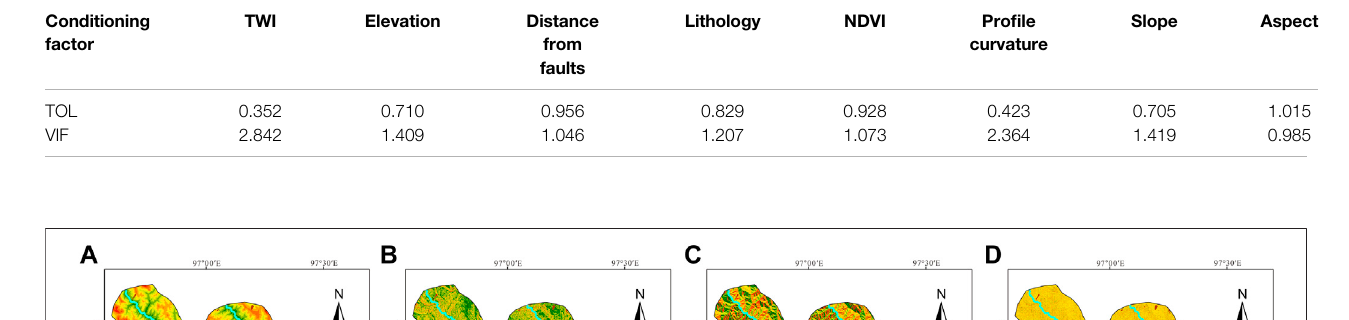
TWI Elevation Distance